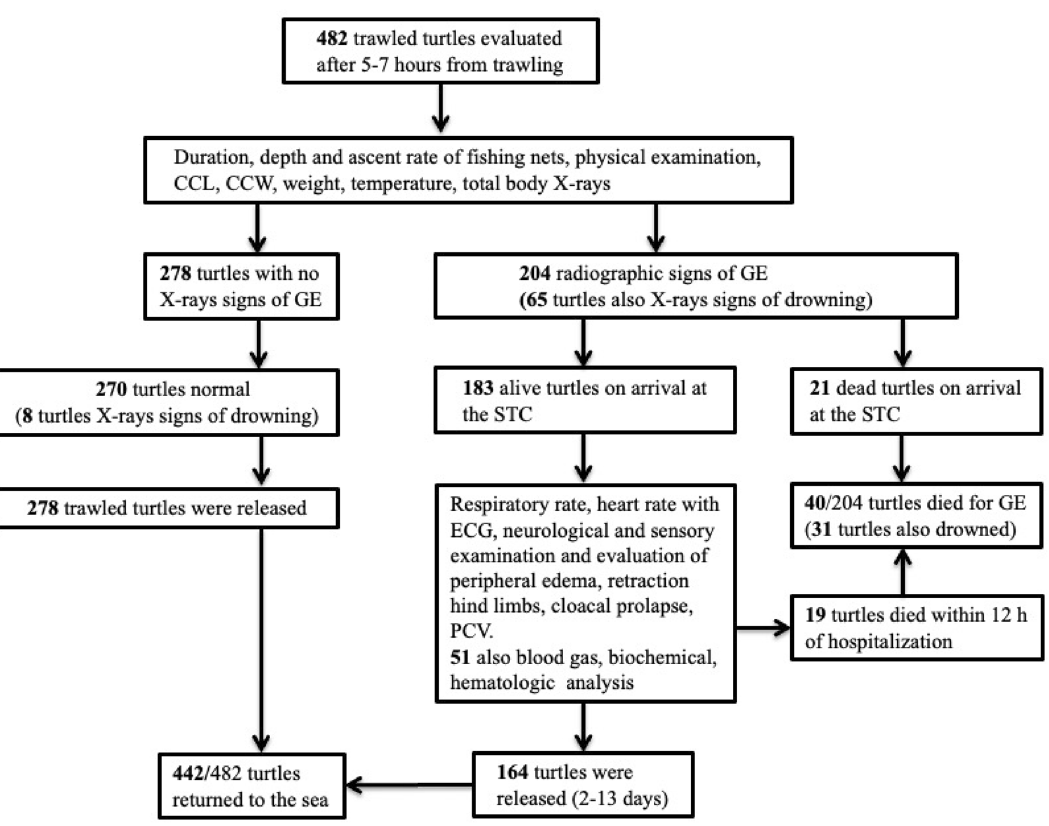
Figure 1. Flowchart of the outcome and clinical findings for 482 loggerhead turtles after being accidentally captured by